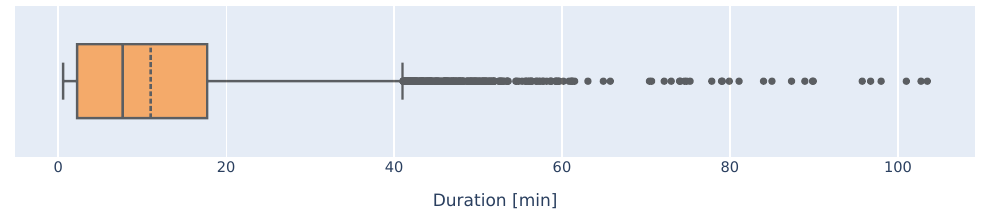
Figure 6. Box plot of the duration during which aircraft affected by RFI in AoI-1 had a NACp value of 0 in